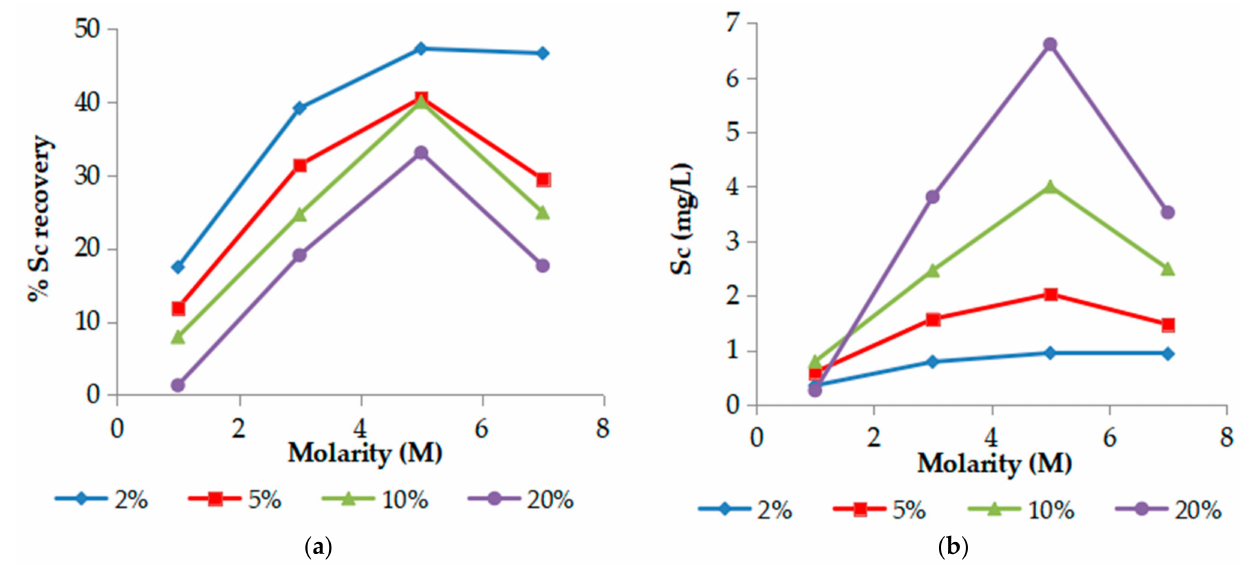
Figure 1. Effect of acid molarity on ( a ) % Sc recovery and ( b ) Sc concentration. (T = 25 ◦ C, t = 60 min).